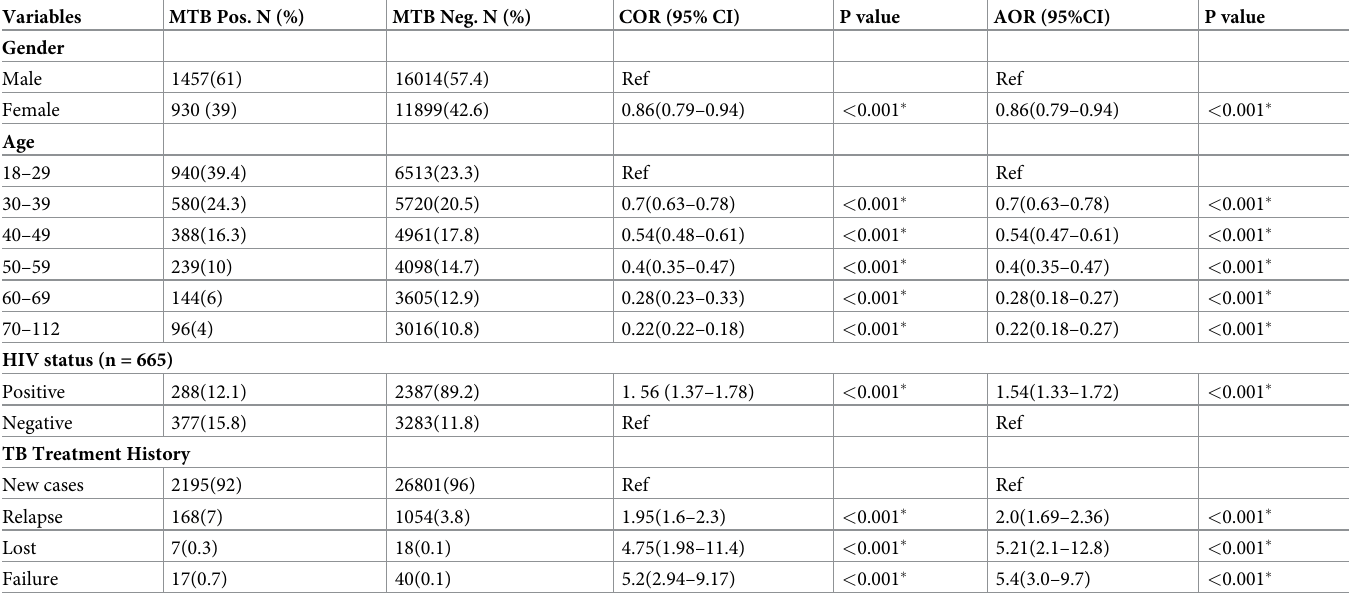
Table 2. Frequency of MTB by gender, age, treatment history, and HIV status in Eastern, Mekelle and Southern Zones of Tigray, Ethiopia, 2016–2019 (N = 30, 300).